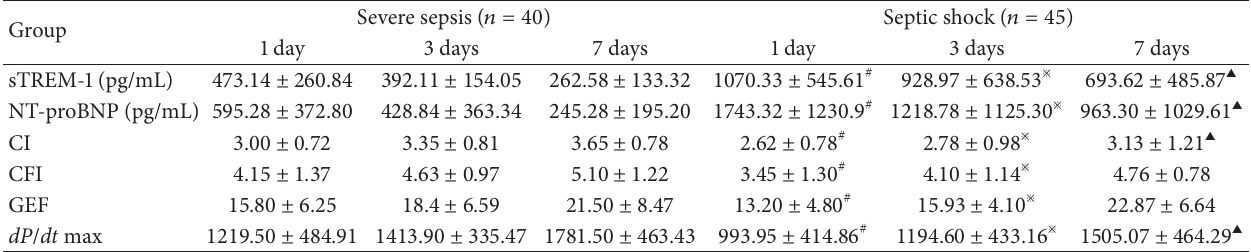
Table 2: Serum concentrations of sTREM-1, NT-proBNP, and CI, CFI, GEF, and dP / dt max in patients with severe sepsis and septic shock on days 1, 3, and 7.